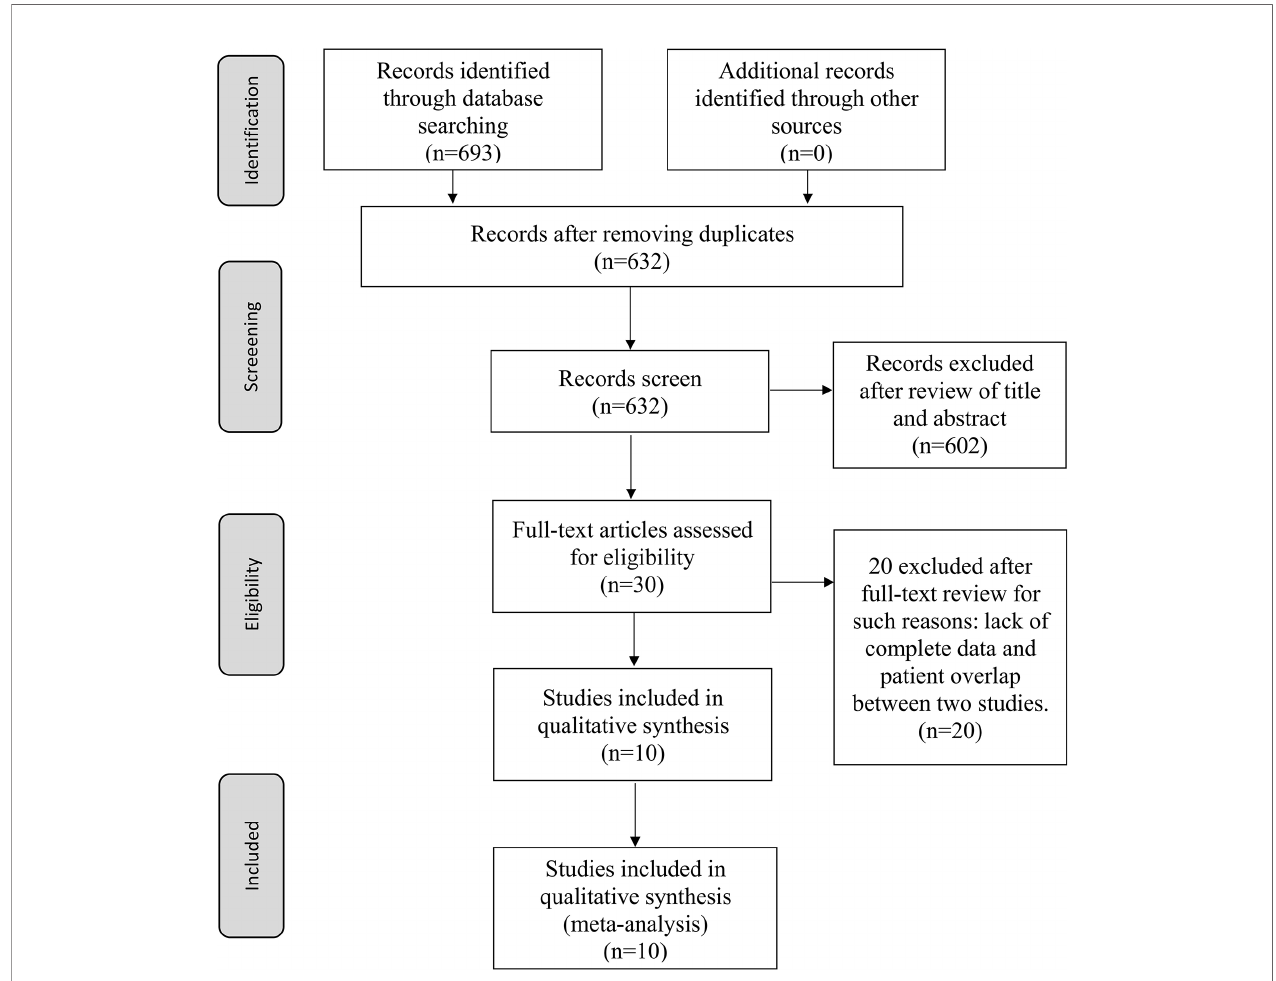
FIGURE 1 | Flow diagram of reviewing and selecting studies.